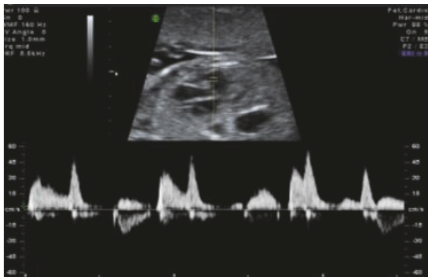
Figure 6: Preserved ventricular contractility (indicated by Frac- tional Shortening of